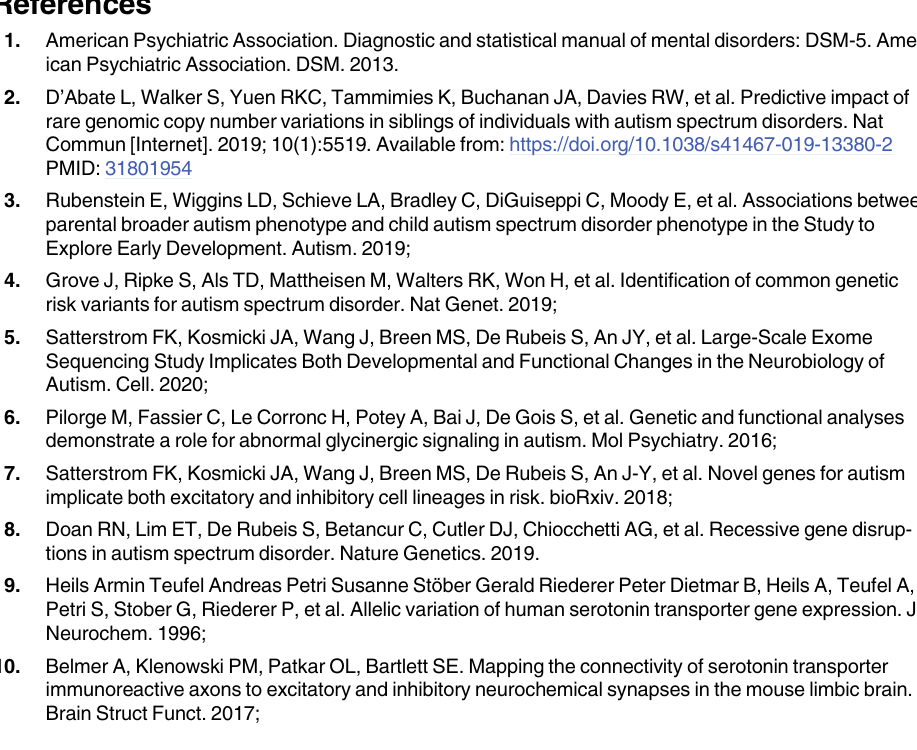
S3 Fig. Funnel plots to evaluate publication bias. a. Funnel plot for S vs L model b. Funnel plot for SS vs SL+LL model, c. Funnel plot for LL vs SL+SS model. S4 Fig. Trim and fill funnel plots. Funnel plots without missing studies a. for S vs L model, b. for SS vs SL+LL model and c. for LL vs SL+SS